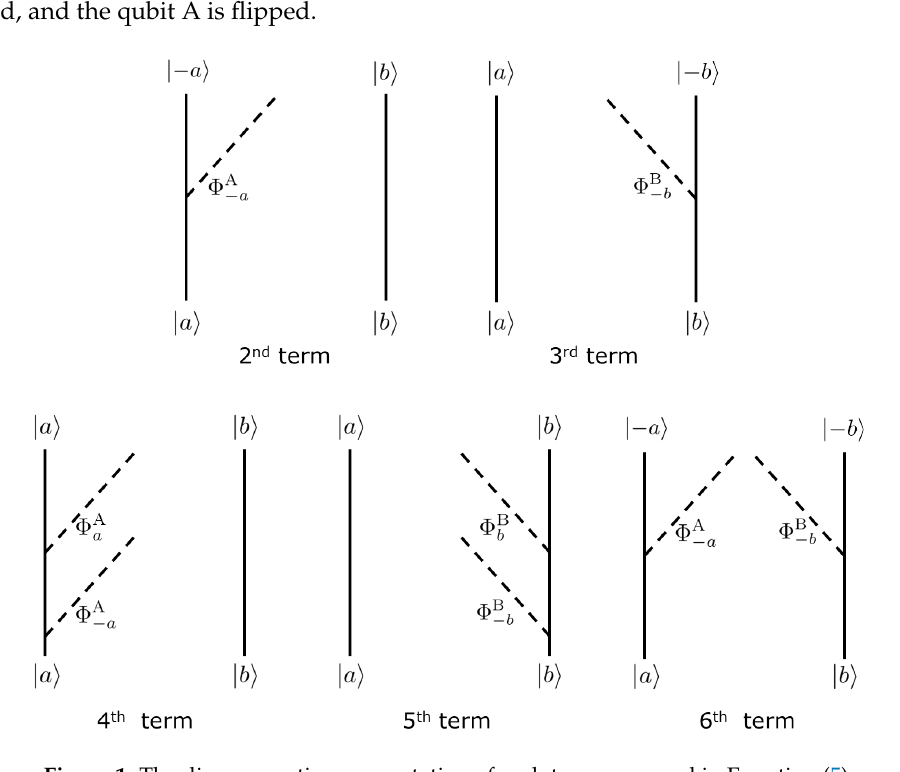
Figure 1. The diagrammatic representation of each term appeared in Equation